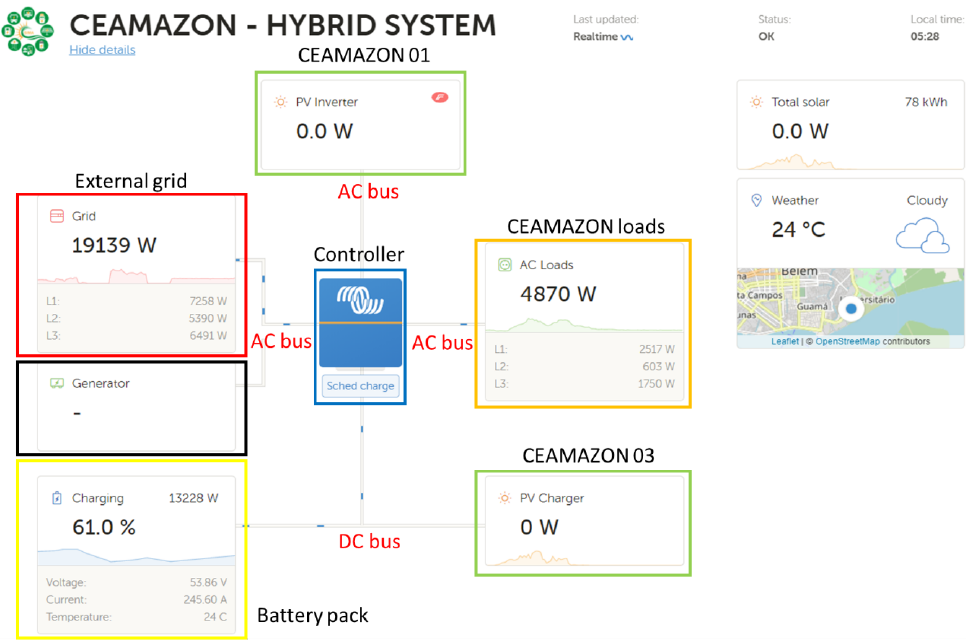
Figure 5. Hybrid system components at control panel at CEAMAZON.